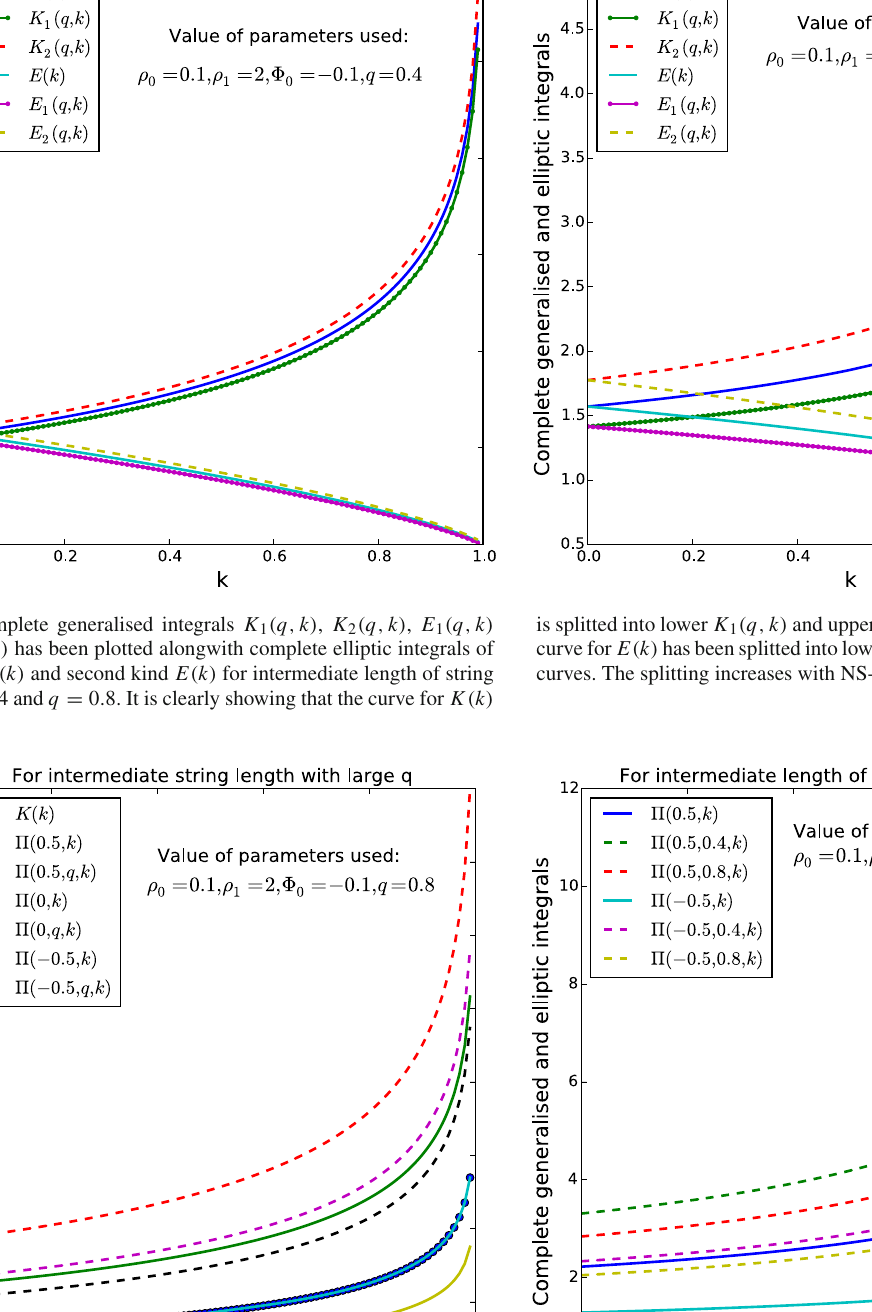
different NS-NS flux. The first plot shows that (cid:14)( n + , q , k ) has always higher value than (cid:14)( n + , k ) for a particular n + . The second plot shows that with increasing q the curve (cid:14)( n + , q , k ) comes closer to (cid:14)( n + , k